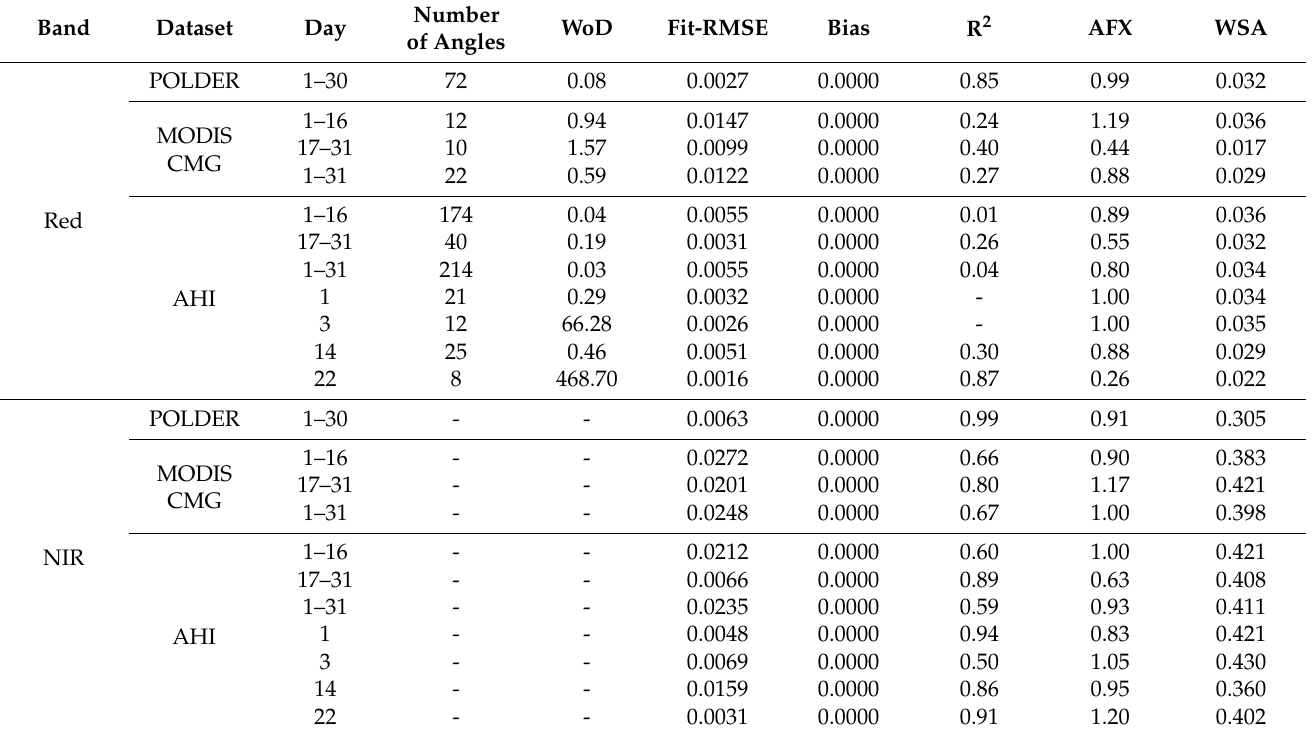
Table 5. Inversion accuracy of the RTLSR_C model based on multiangle observations from POLDER, MODIS, and